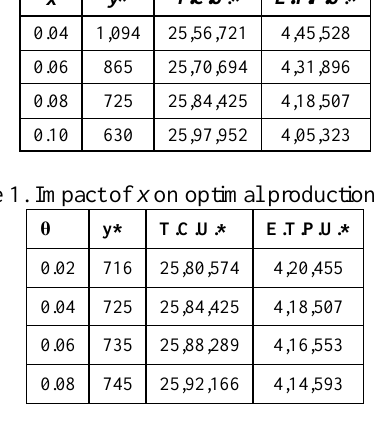
Table 2. Impact of θ on optimal production